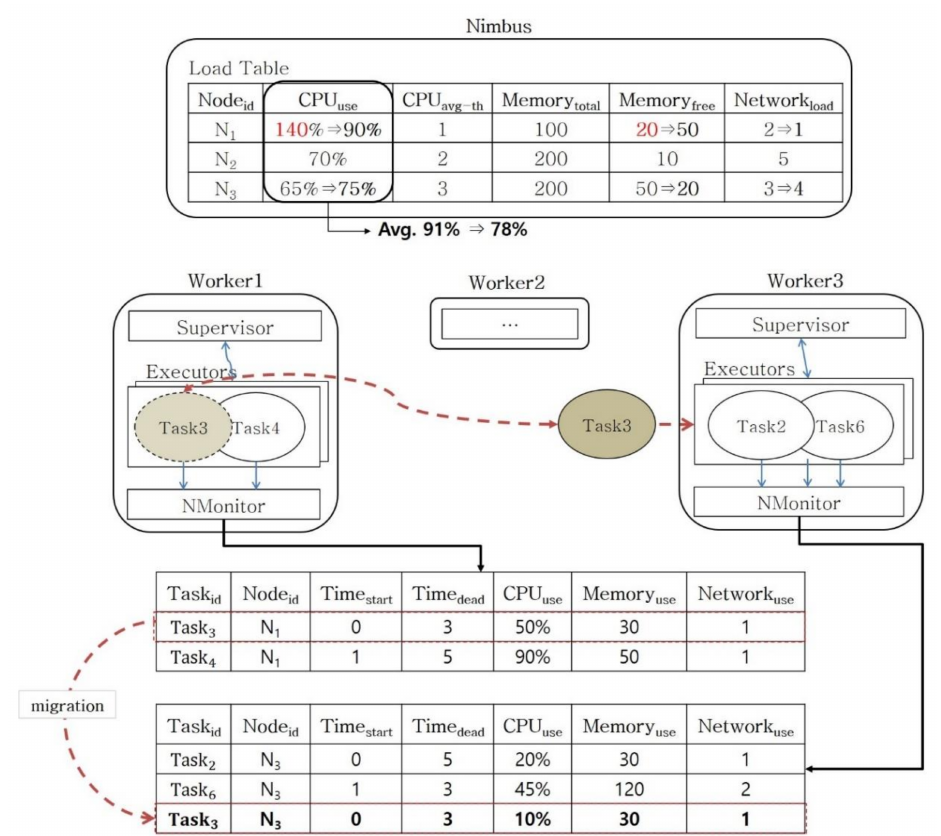
Figure 6. CPU and memory load-based scheduling.